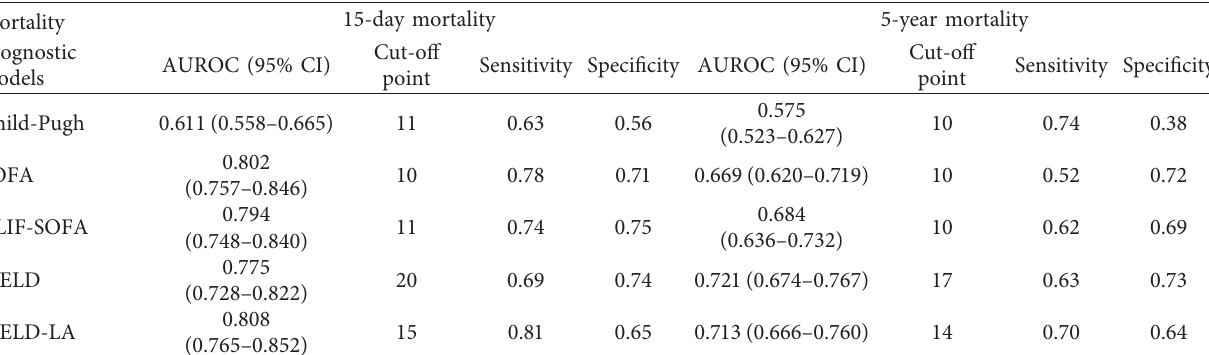
Figure 4: Receiver operating characteristic curves of the scoring systems for (a) 15-day and (b) 5-year mortality in critically ill patients with cirrhosis caused by hepatitis alone. SOFA, sequential organ failure assessment; CLIF-SOFA, chronic liver failure-sequential organ failure assessment; MELD, model for end-stage liver disease; MELD-LA, model for end-stage liver disease-lactate. Table 2: Model discrimination for mortality in the whole study population.